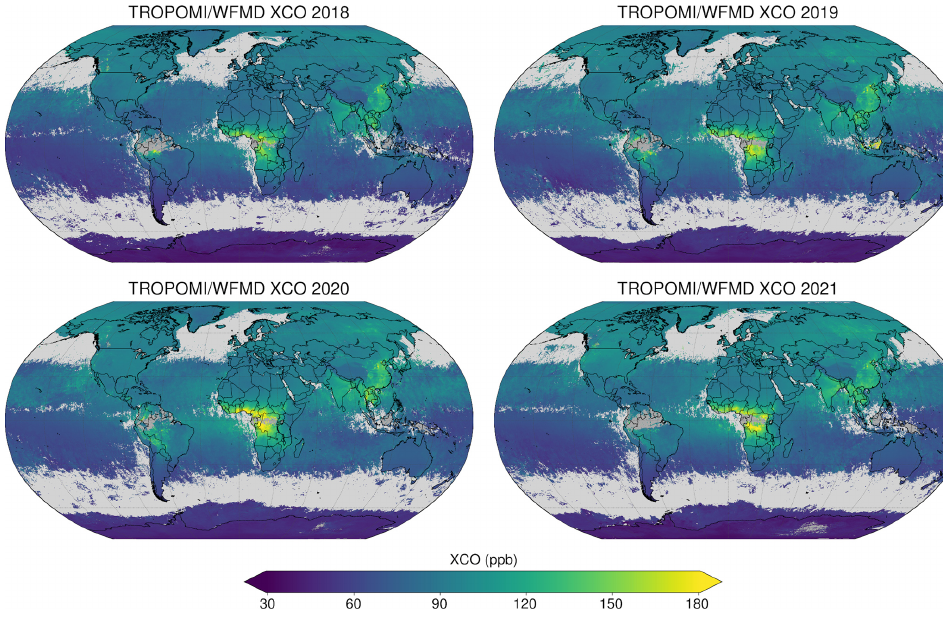
Figure 20. As Fig. 19 but for TROPOMI/WFMD v1.8 XCO.